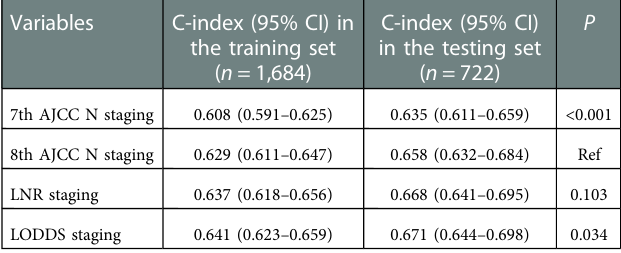
TABLE 3 The predicting ability of four staging systems for OS between training set and testing set. Variables